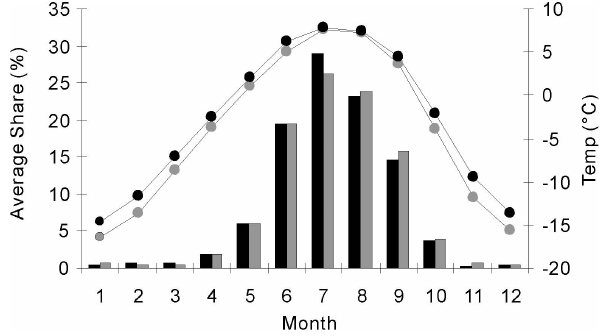
Fig. 2. Monthly distribution of precipitation (bars) and temperature (lines) for Tuotuohe (in black) and Amdo (in grey) meteorological